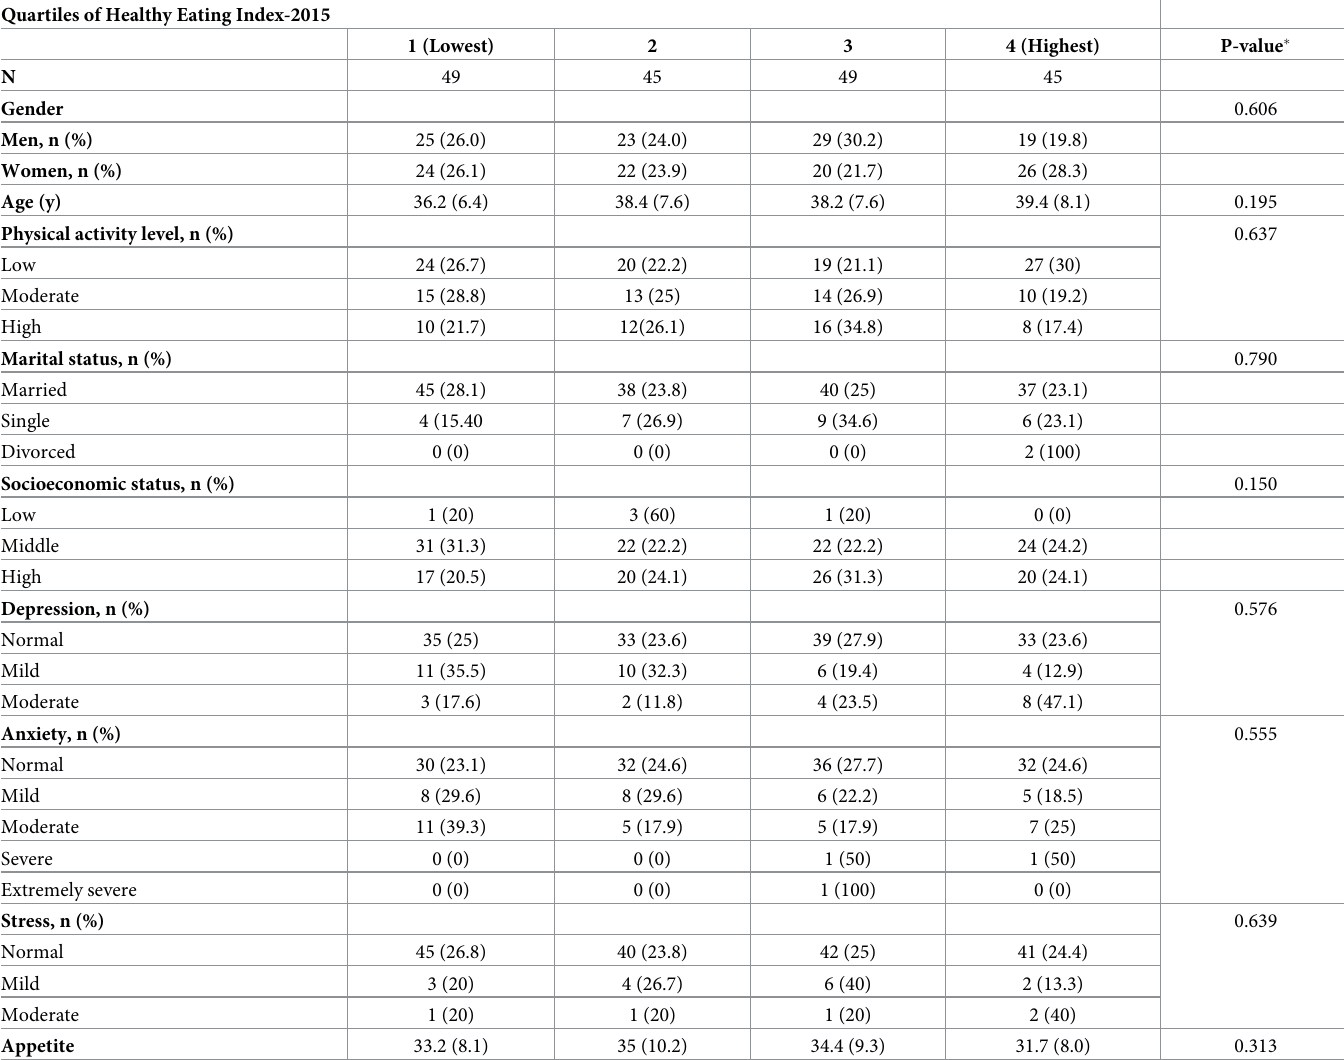
Table 2. General characteristics of study participants by quartiles of Healthy Eating